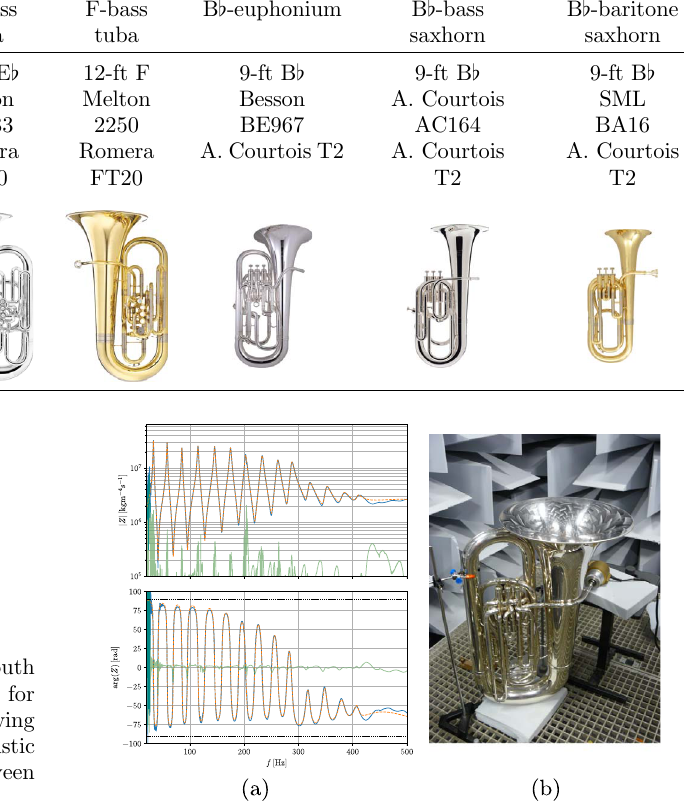
Figure 3. Left: modulus (top) and phase (bottom) of the input impedance of the B [ -contrabass tuba with respect to frequency. Blue curve: measured impedance; dashed orange curve: modal fi t function with N = 13 modes; green curve: error between measured and fi tted impedances, de fi ned by Z fit j j (cid:3) Z exp arg( Z fi t ) (cid:3) arg( Z exp ) as regards the modulus and phase, respectively. Right: photograph of the experimental set-up for the measure of the input impedance of the B [ -contrabass tuba, displaying the device described in [35], here mounted on the tuba ’ s mouthpiece. (a) Input impedance as a function of frequency. (b) Experimental set-up.